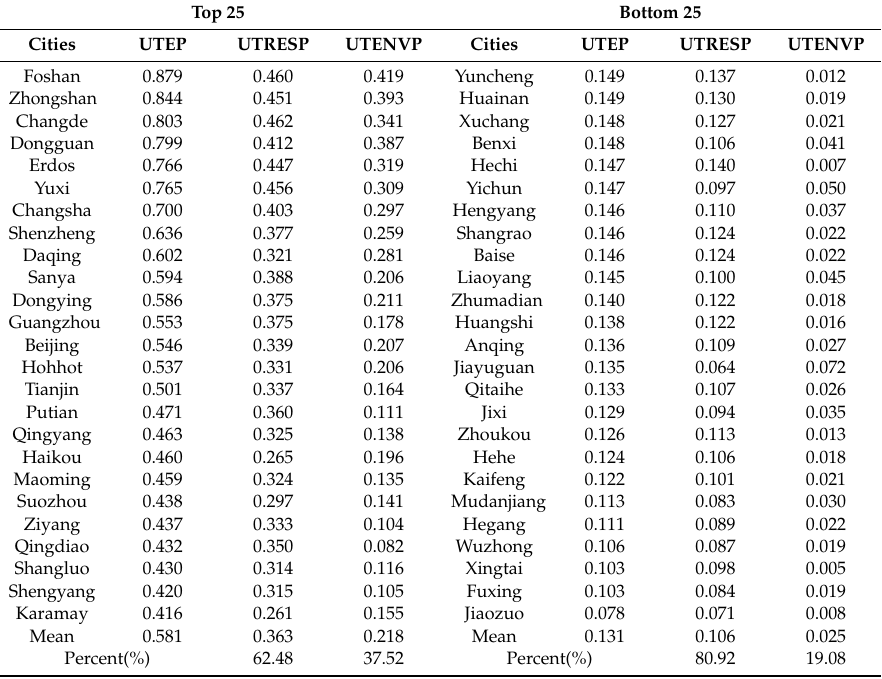
Table A1. The average and decomposition of UTEP of the top 25 and bottom 25 cities from 2004 to 2016. Top 25 Bottom 25 Cities UTEP UTRESP UTENVP